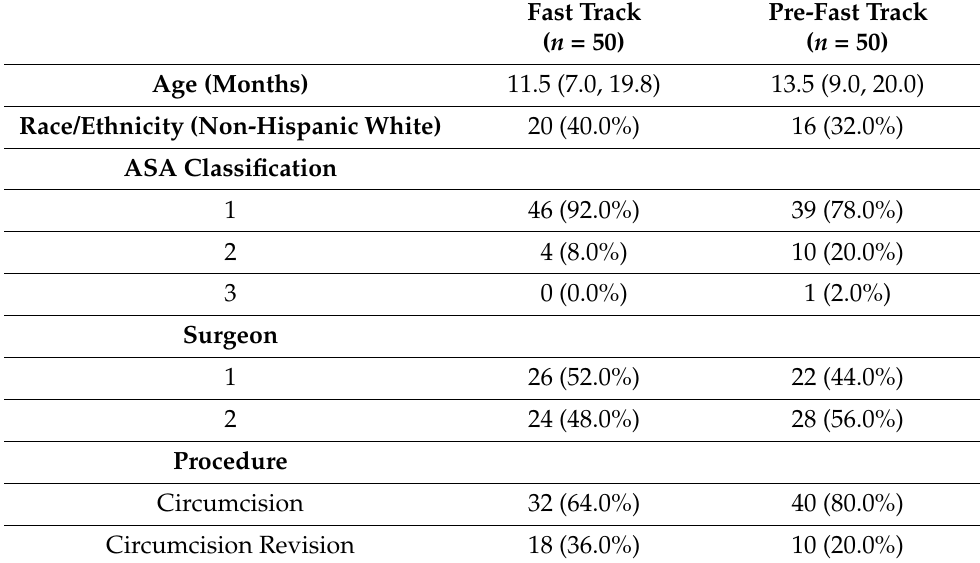
Table 2. Patient Demographics and Preoperative Characteristics.